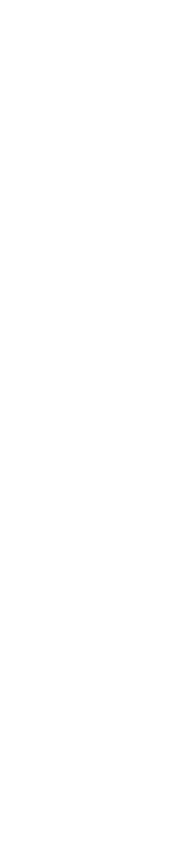
recommended by the American Heart Association Standardized Myocardial Segmentation and Nomenclature for Imaging Guidelines (Fig. 2)